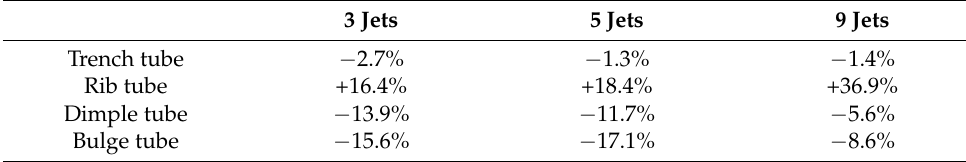
Table 4. Pressure loss for the structured tube compared with the smooth tube with different jets at Re D =